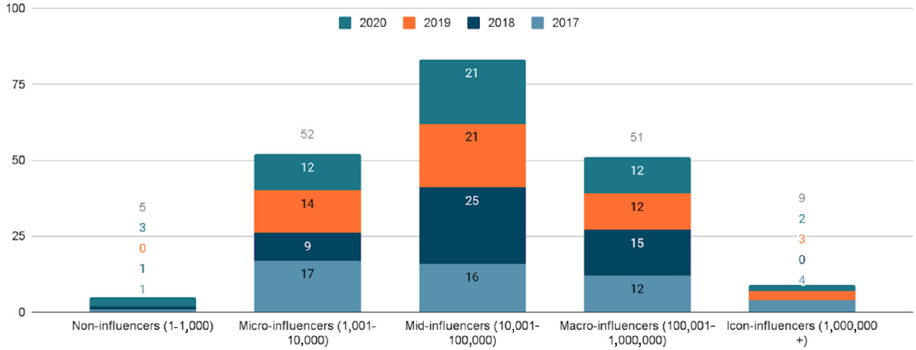
Figure 7. Aggregated number of followers of the accounts that the sample of Spanish deputies started to follow in 2017, 2018, 2019 and 2020.